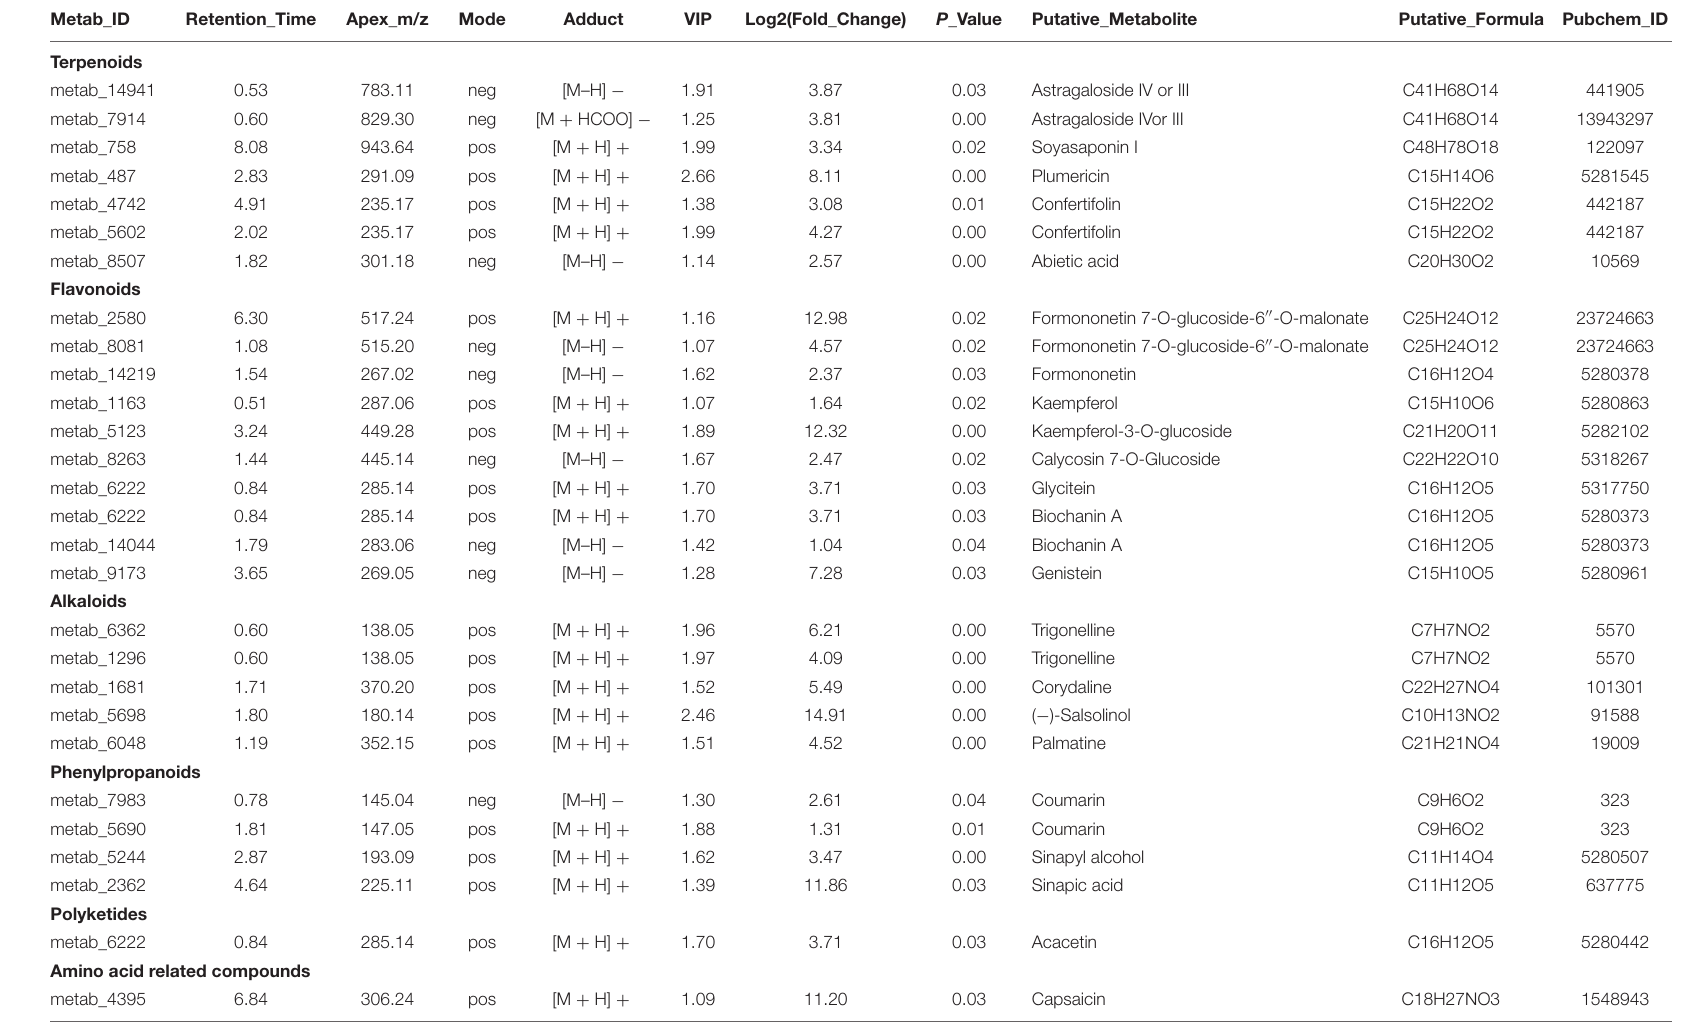
TABLE 2 | Differential pythometabolites for comparison between AMM and control